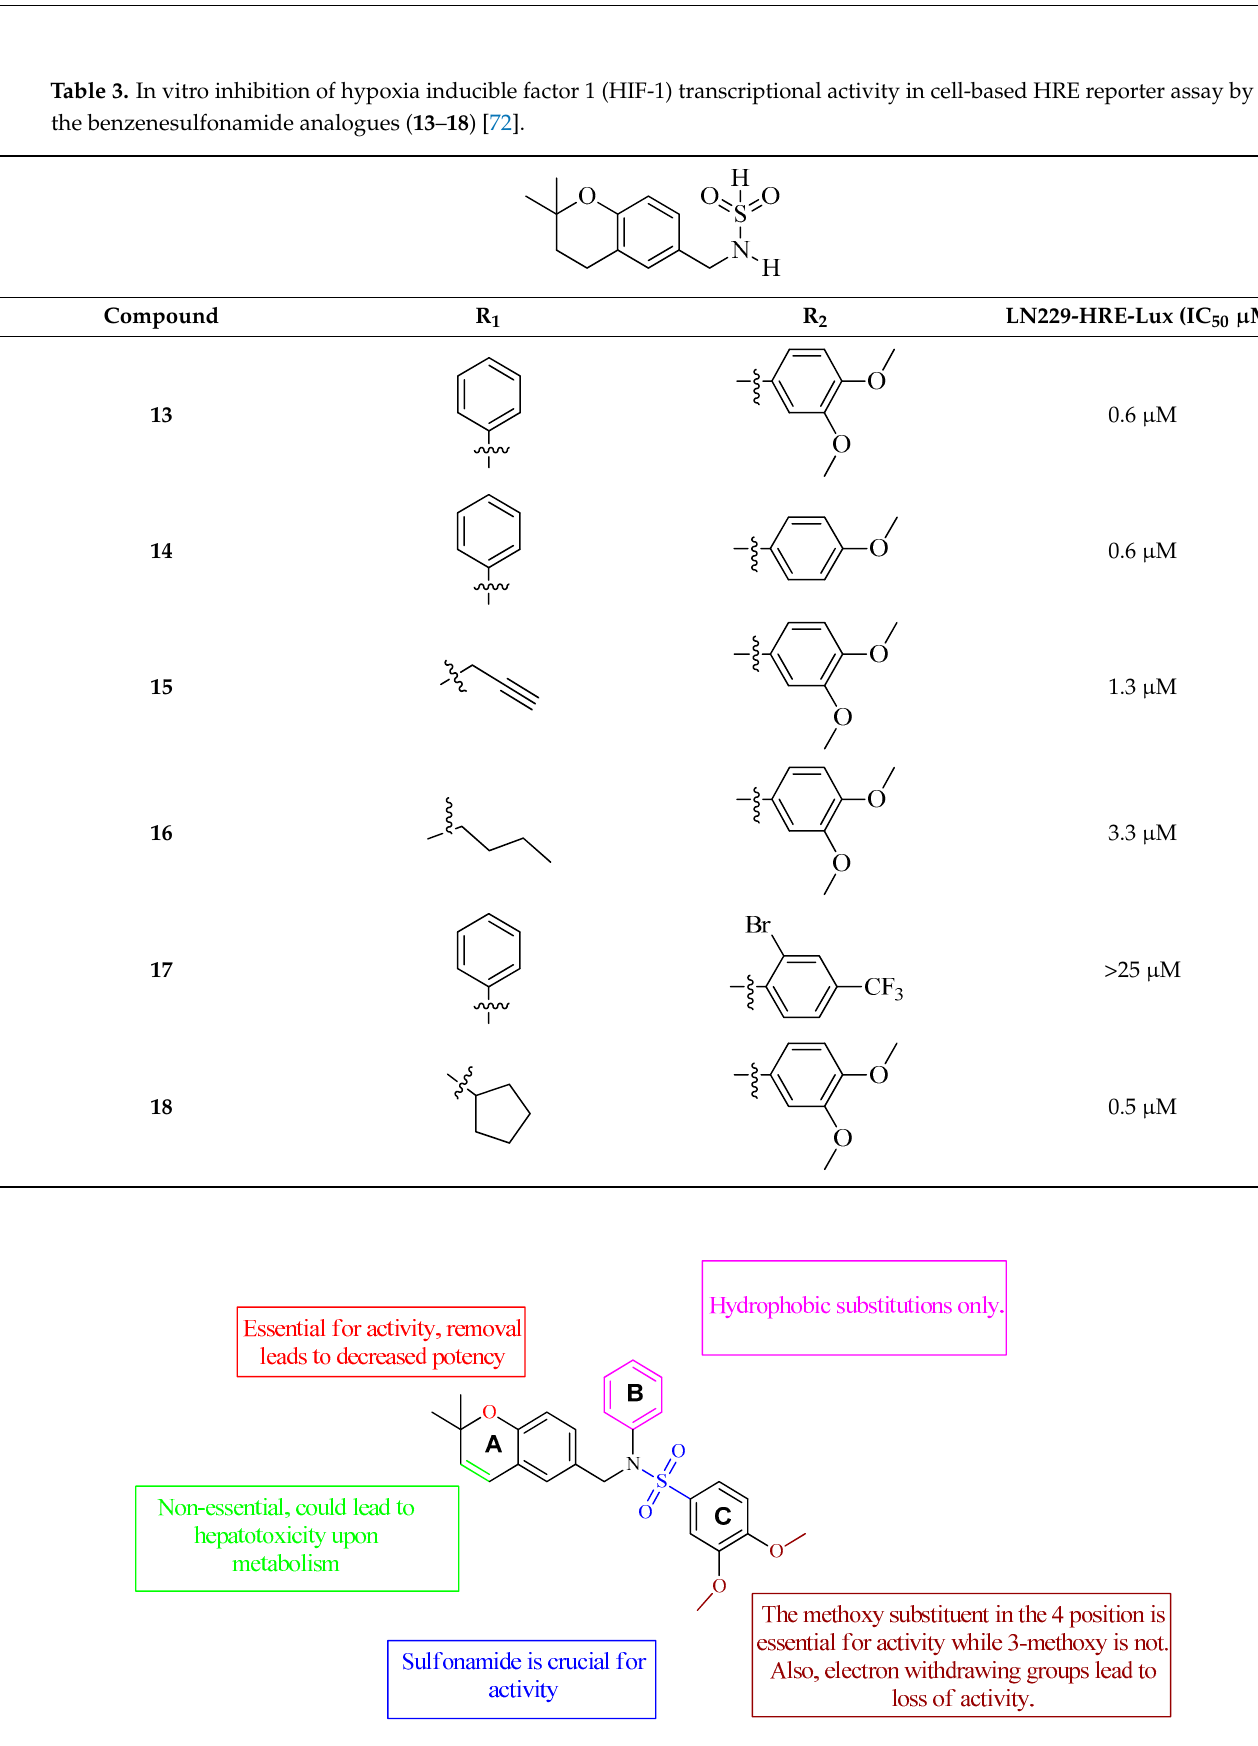
Figure 7. Structure–activity relationship study of the benzenesulfonamide hits and its analogues